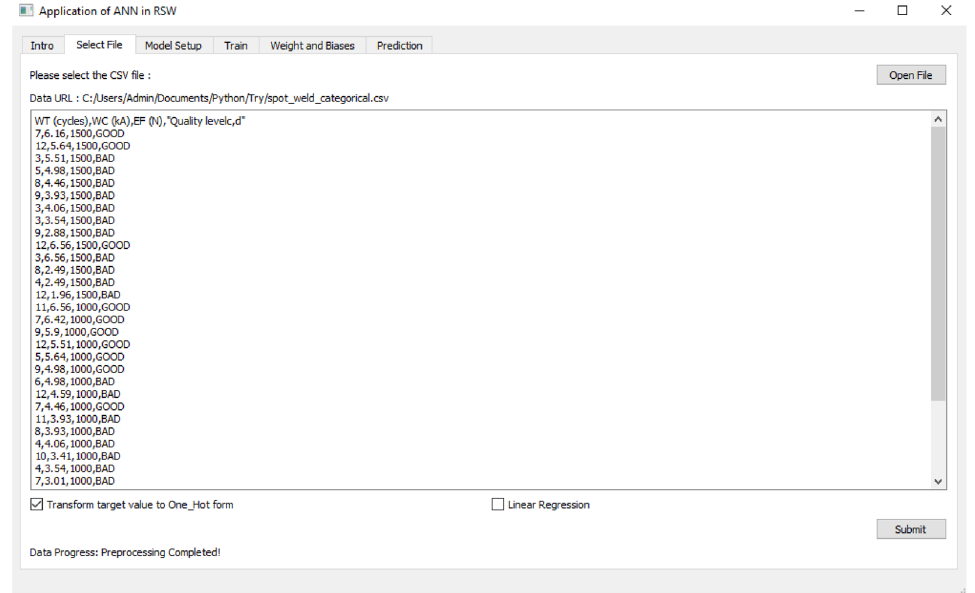
Figure 6. Import and pre-processing of the dataset as Tab